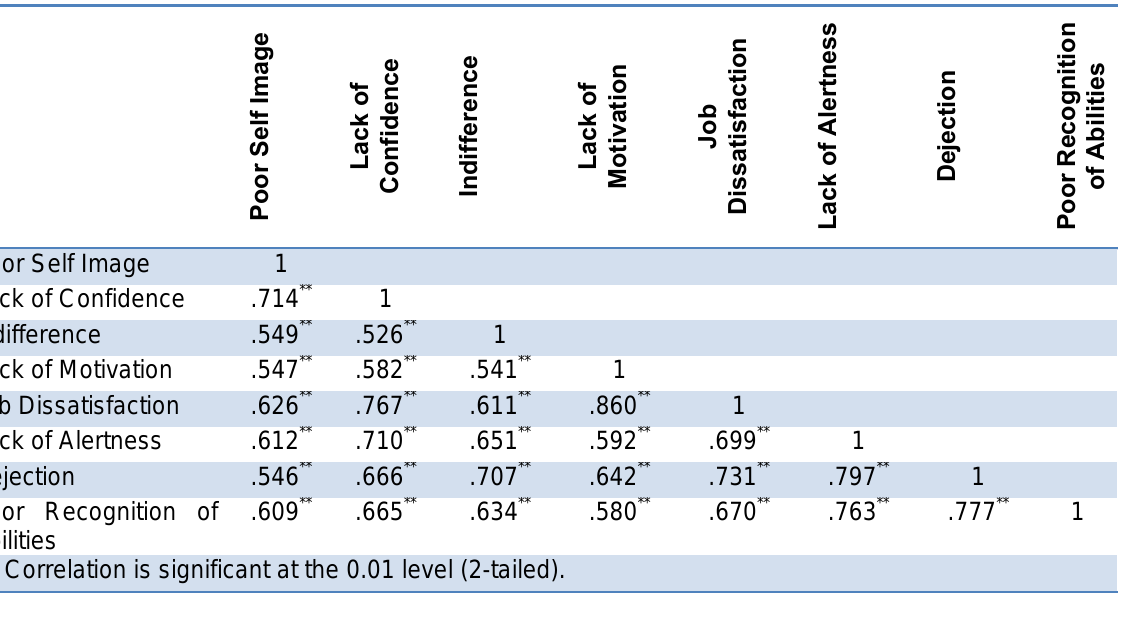
Table 6: Pearson correlation coefficients for job satisfaction effects